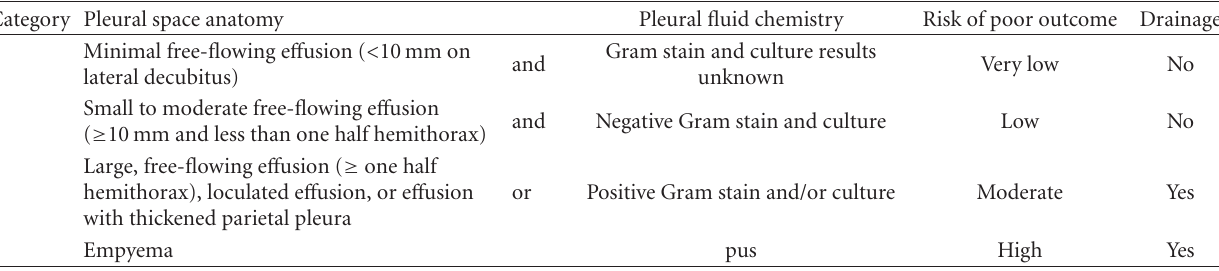
Table 1: Pleural infections staging and recommended drainage [7].